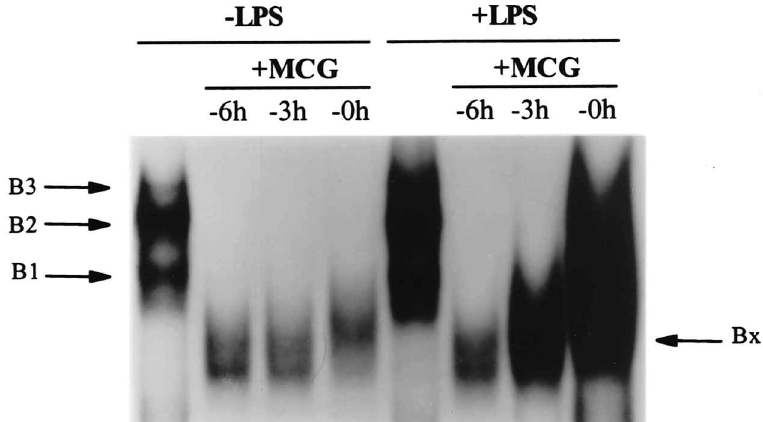
FIG. 6. Effect of MCG exposure on NF- k B proteins in mouse peritoneal macrophages. Murine peritoneal macrophages were cultured with MCG for 6, 3 or 0h at a macrophage to mast cell ratio of 5 to 1 prior to a 30min incubation in the absence or presence of LPS (10ng/ml). After incubation, the cells were washed, nuclear proteins were extracted from each group of cells and were subjected to EMSA using radiolabelled NF- k B oligonucleotide as described in the Experimental section.